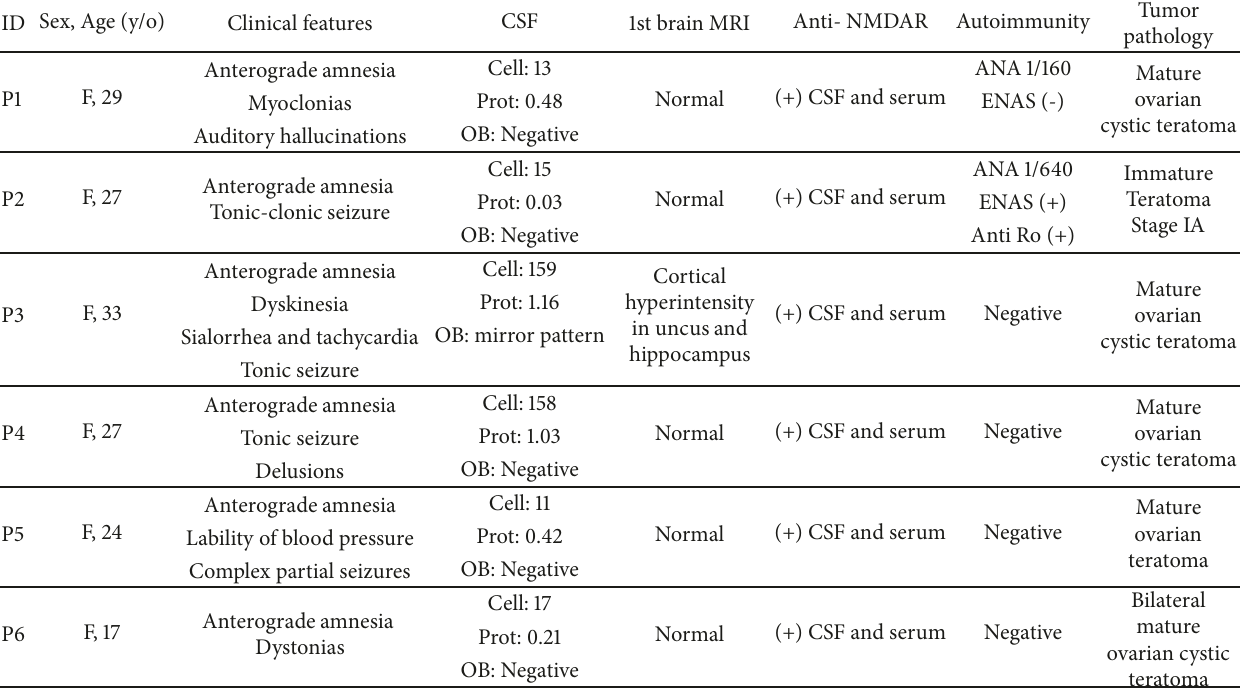
Table 1: Clinical and immunological features of patients with Anti-NMDAR